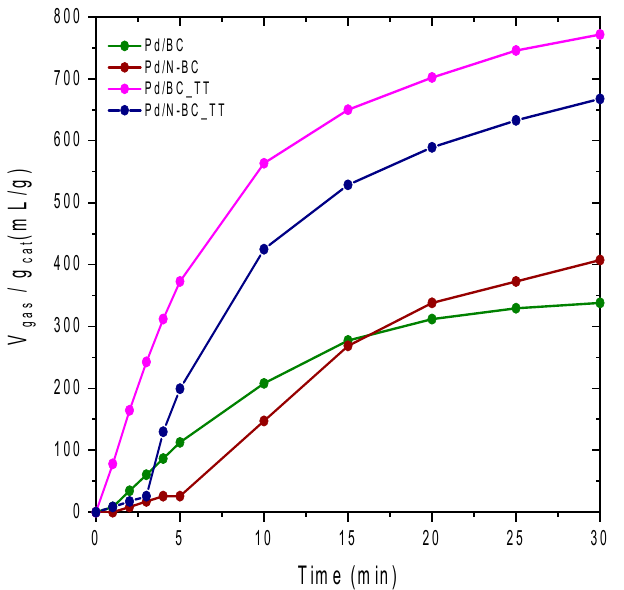
Figure 4. Gas evolution profiles (H 2 + CO 2 ) attained by Pd/BC, Pd/BC_TT, Pd/N-BC, and Pd/N- BC_TT in the first reaction cycle.